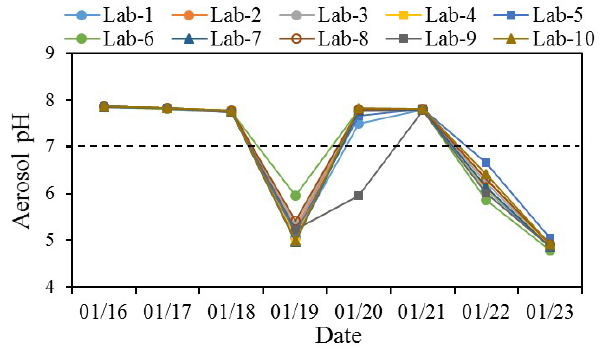
Figure 5. Aerosol pH estimated by ISORROPIA II using ions and ammonia in the 10 labs from 16 to 23 January